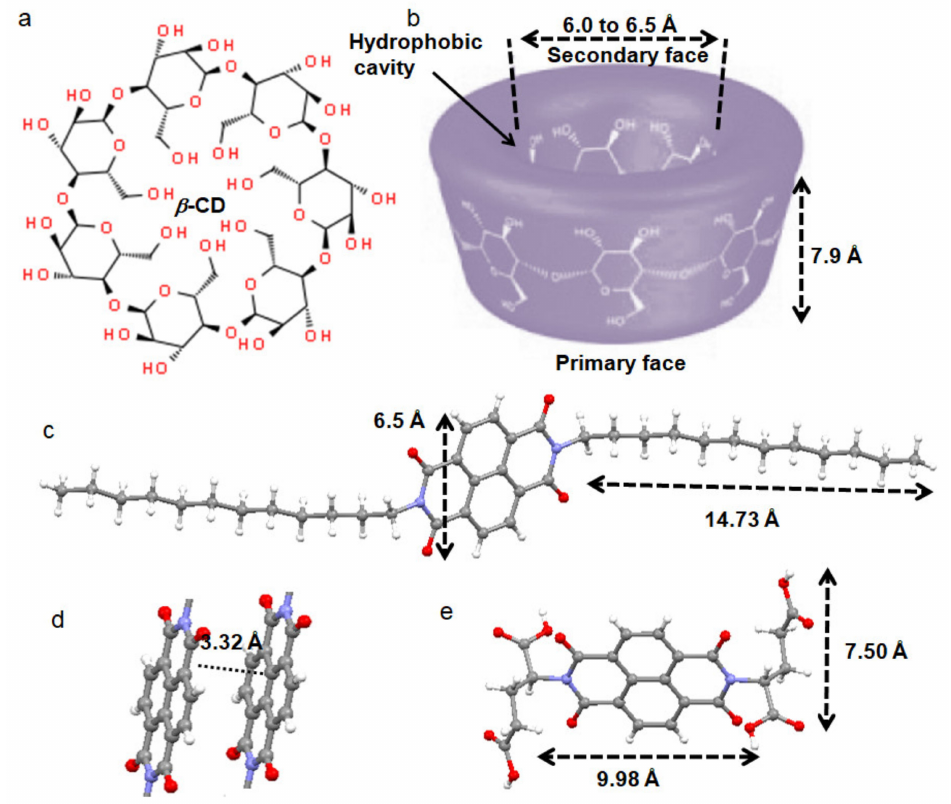
Figure 1. ( a )The chemical structure of β -CD; ( b ) The graphic showing the 3D shape and cavity of β -CD; ( c ) The solid-state structure of NDI 1 ; ( d ) The face to face π - π stacking interaction between the naphthalenediimide central core of NDI 1 ; ( e ) The solid-state structure of NDI 2